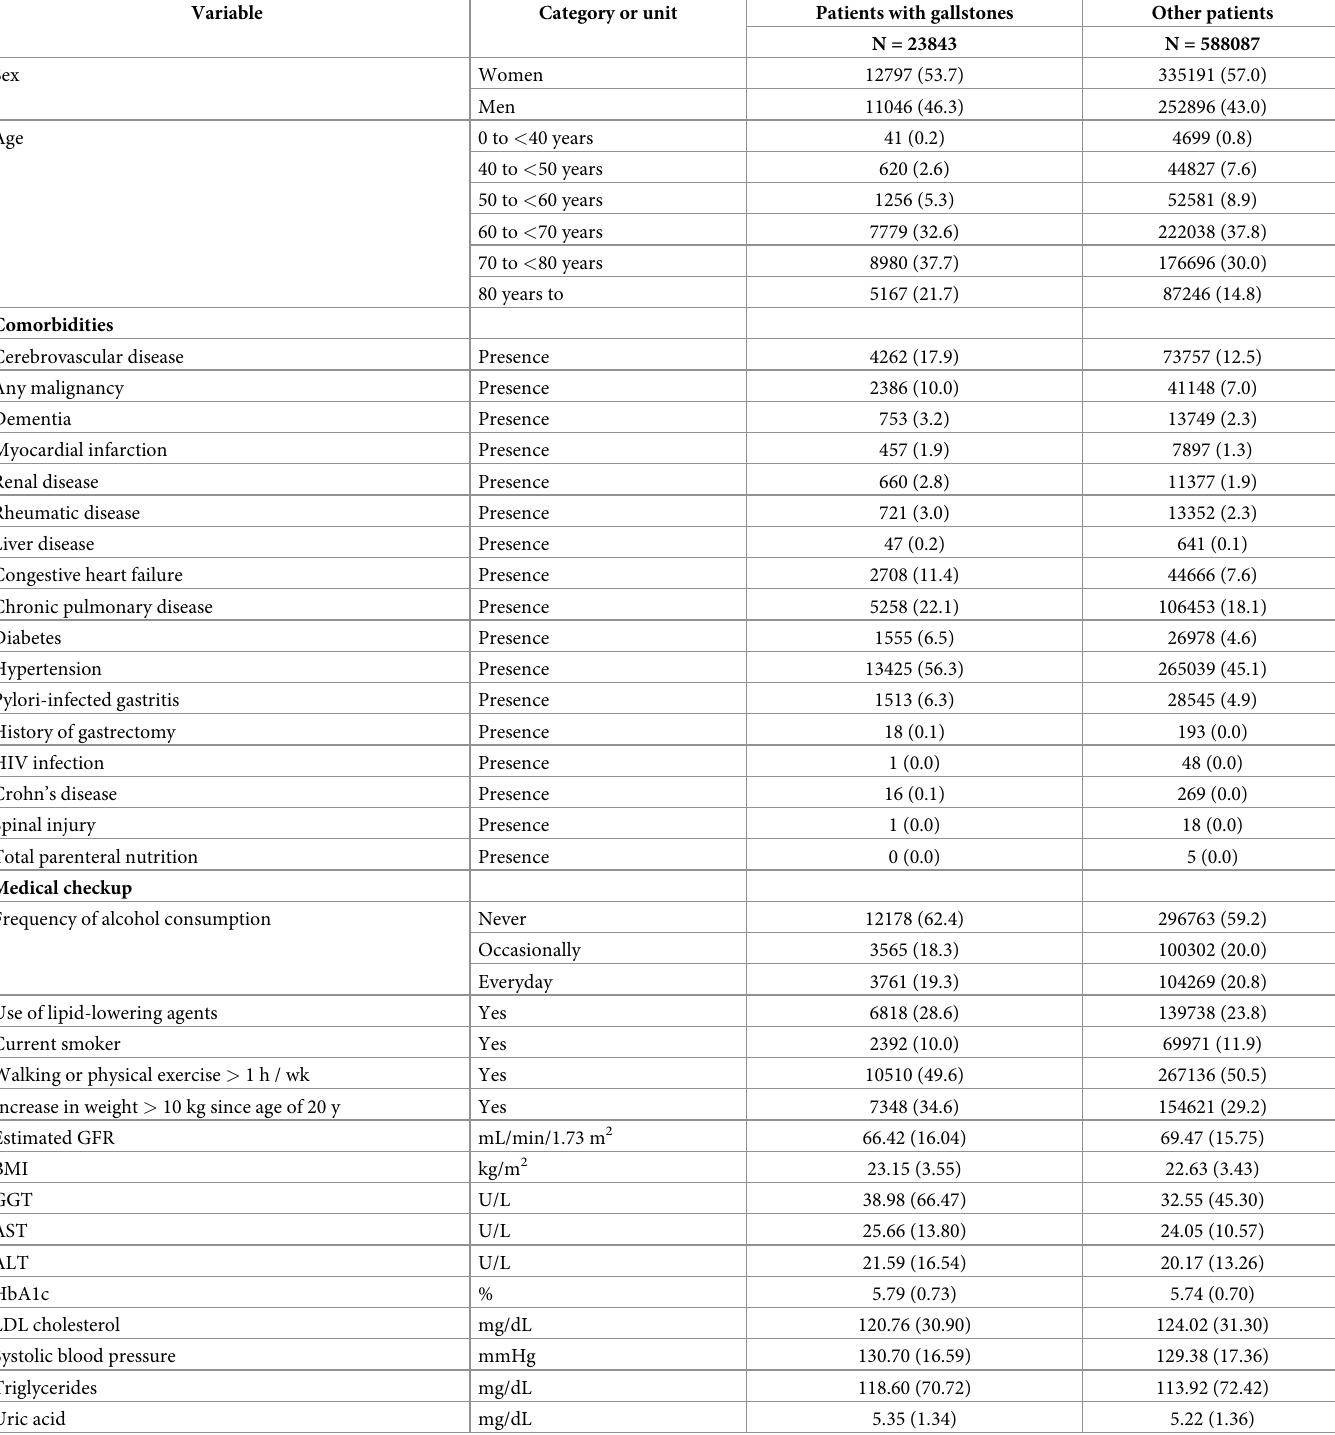
Table 1. Participant characteristics and variables for univariable Cox model